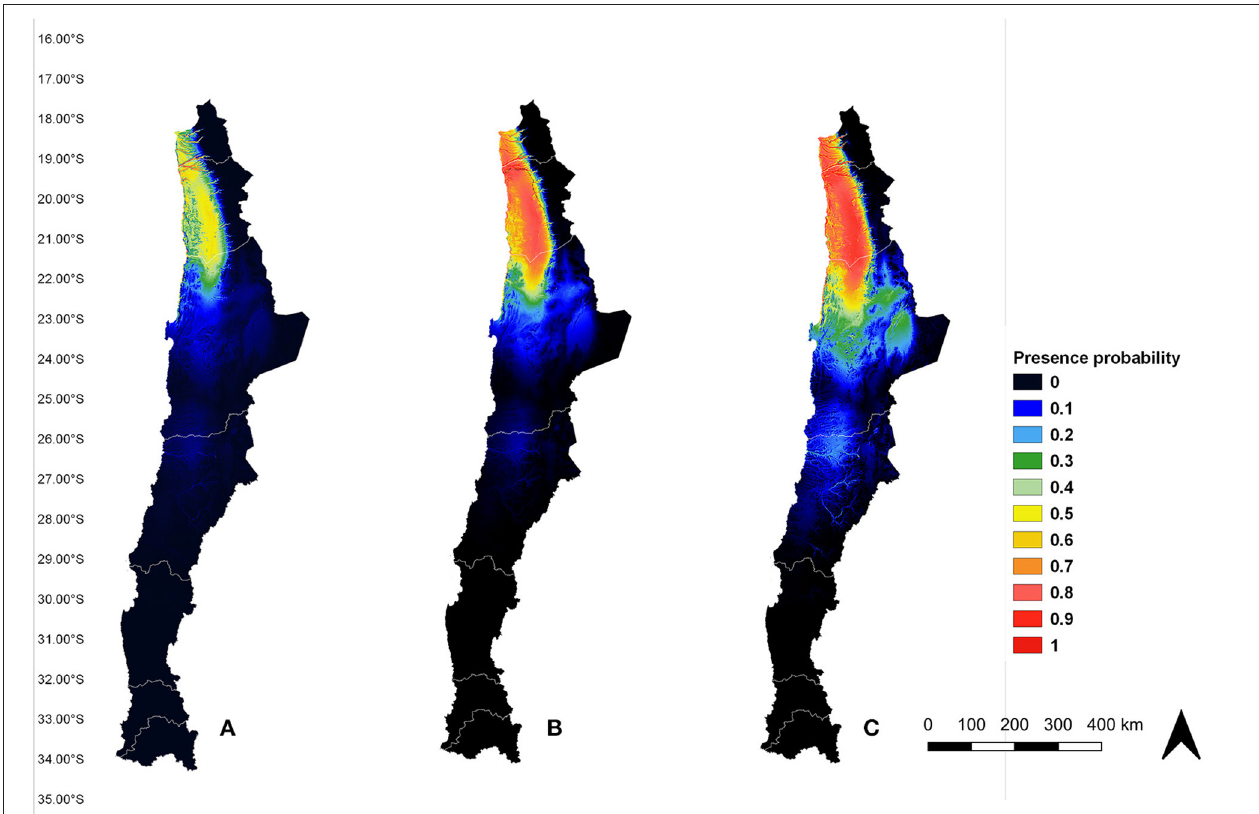
FIGURE 4 | An. (Ano.) pseudopunctipennis potential distribution model in Chile under current (A) , RCP 4.5 (B) , and RCP 8.5 (C) scenarios. Model GF.